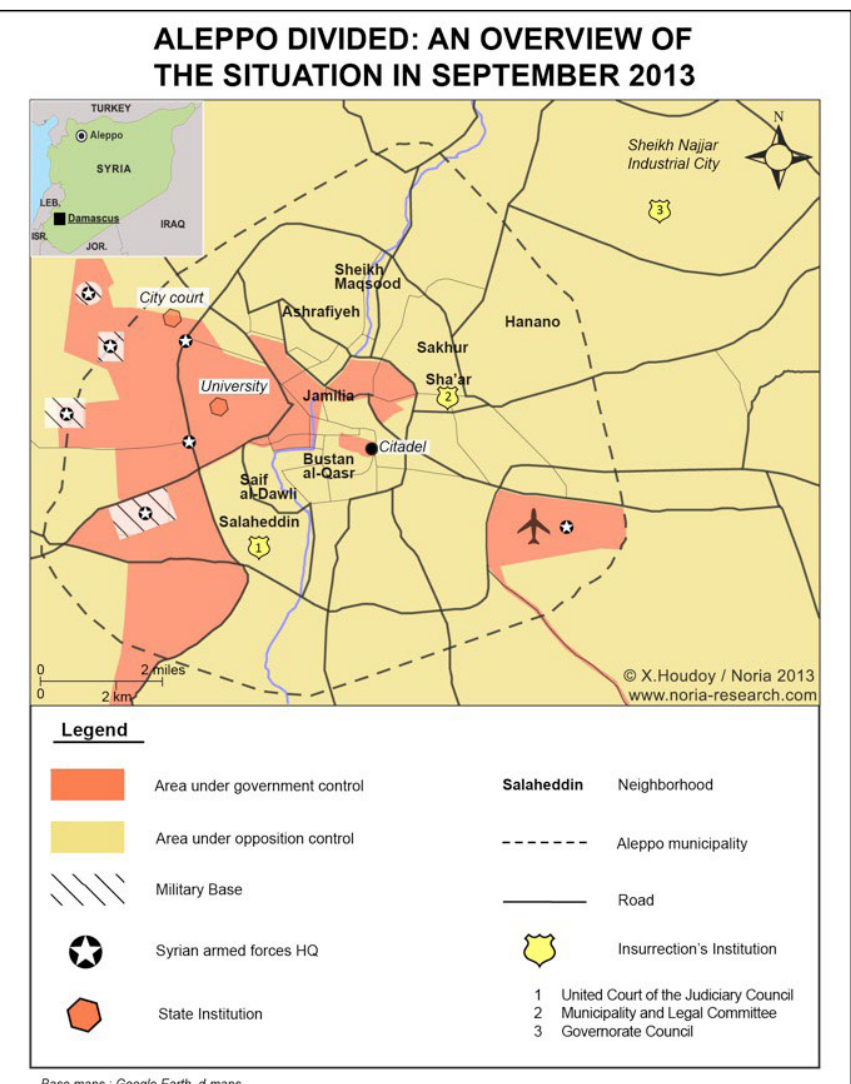
Figure 1: Aleppo territorial control in September